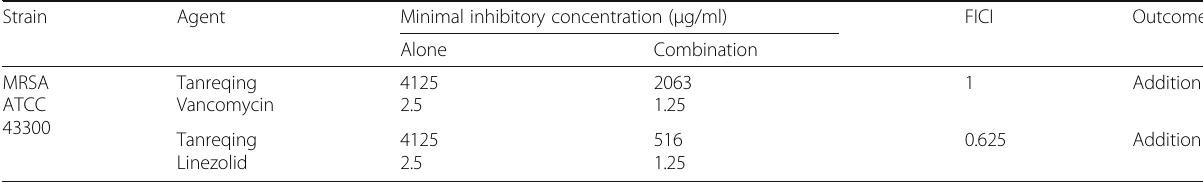
Table 1 Minimal inhibitory concentration (MIC) and fractional inhibitory concentration index (FICI) of Tanreqing, vancomycin and linezolid against MRSA